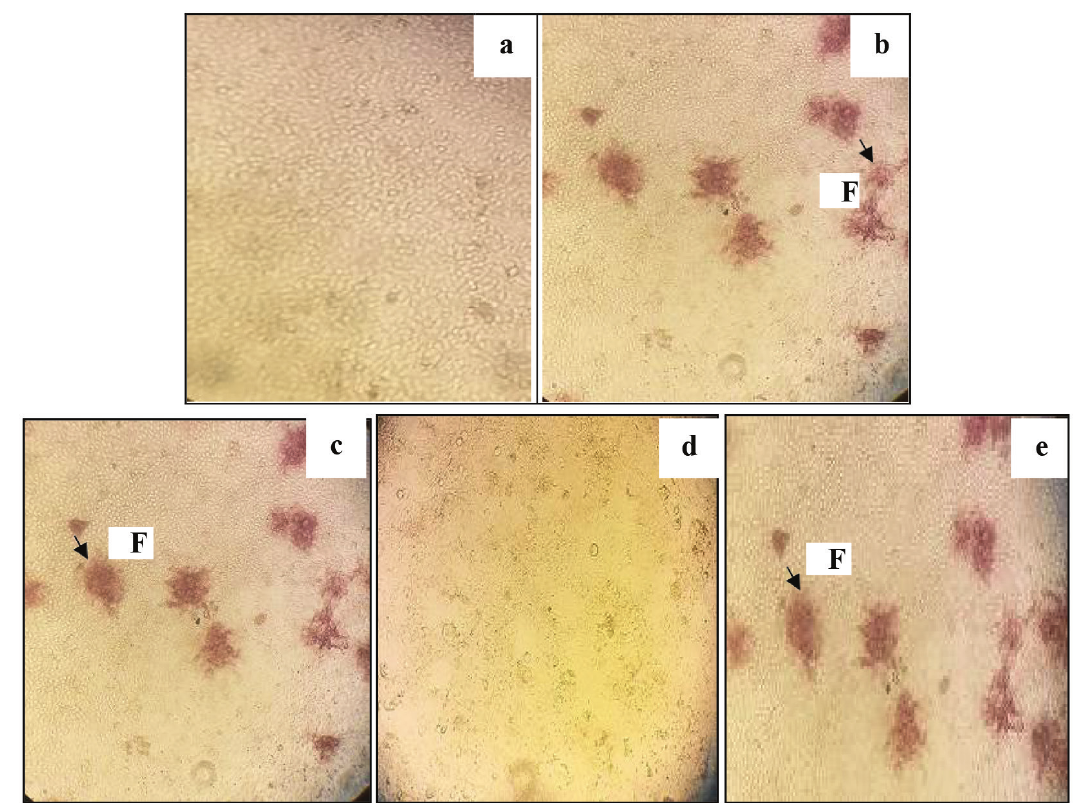
Figure 3. Immunostaining Results of the DENV-2 on focus assay. F = foccus ( A ) Normal.